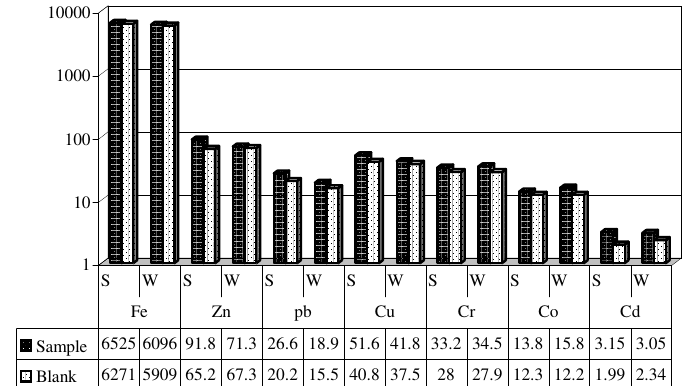
Figure 7. Heavy metals (ppm) in summer and winter seasons, for < 0.630 mm sizes of particles. ( S: Summer season W: Winter season